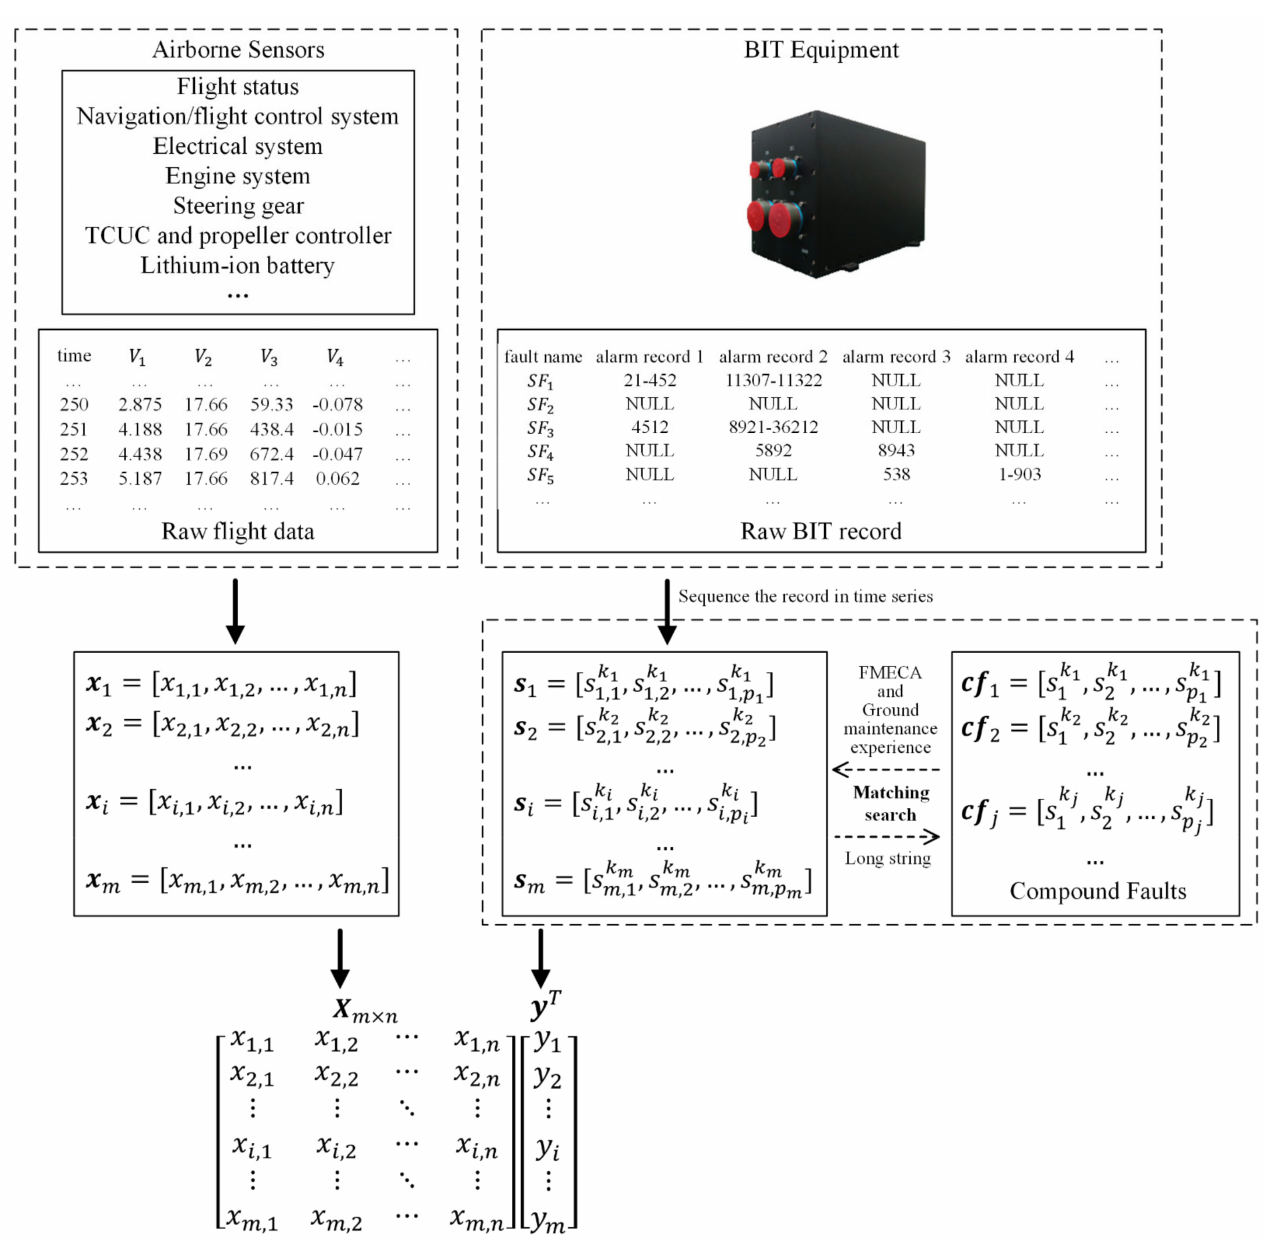
Figure 2. Data assembling and labeling method of flight data and BIT